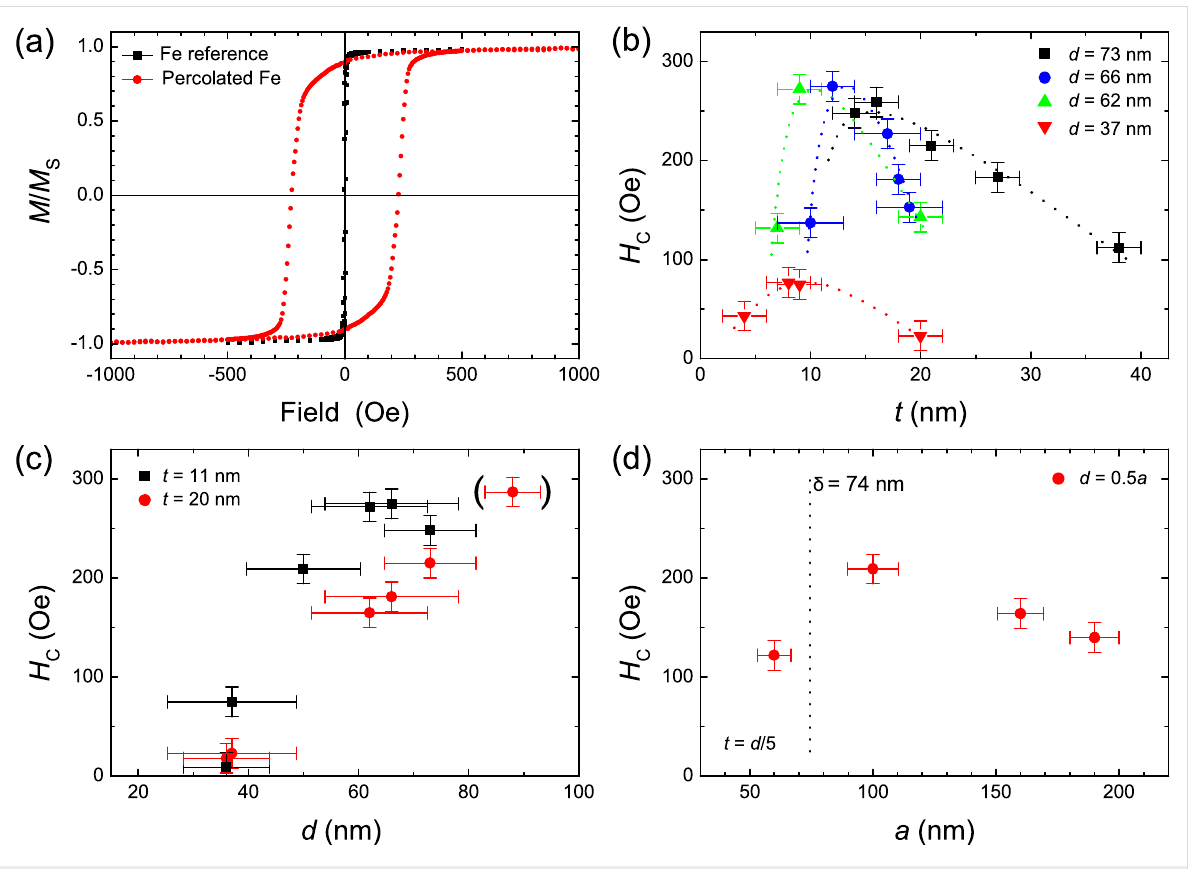
Figure 5: (a) Magnetic hysteresis loops of a percolated Fe film ( a = 95 nm, d = 66 nm, t = 17 nm) and a thin-film reference sample taken in the in-plane geometry at ambient temperature. Panel (b) shows the experimental coercive field as a function of Fe layer thickness t for different diame- ters d of PS spheres at a distance a = 95 nm. Dotted lines are guides to the eye. In (c) H C is presented as a function of d at a = 95 nm for two layer thicknesses t . In panel (d) the coercive field is displayed as a function of the sample periodicity a for PS sphere diameter d = 0.5 a and optimized Fe film thickness t = d /5. Additionally, the experimentally determined domain wall width δ = 74 nm of continuous Fe films is